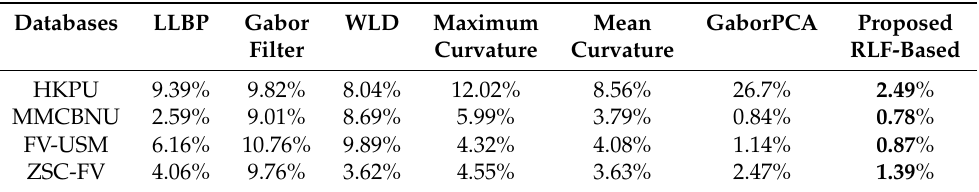
Figure 11. FAR-FRR curves of compared methods on four finger vein databases, the margin parame- ters are c w = 40, c h = 40. Table 3. EERs obtained by using different methods on four finger vein databases, the margin parameters are c w = 30, c h = 30.